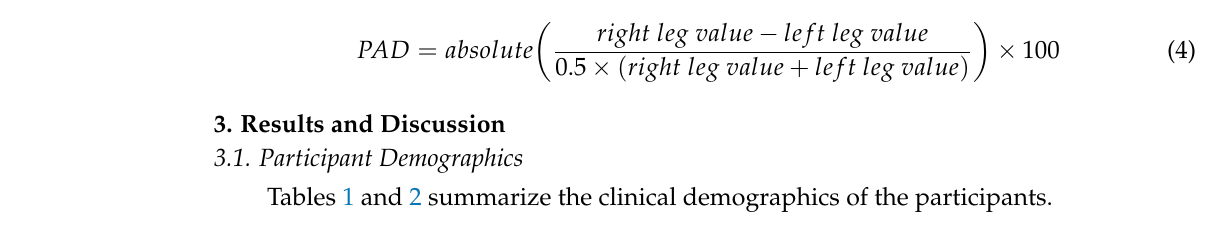
Table 1. Participants’ JIA diagnosis and details of clinical assessment findings.